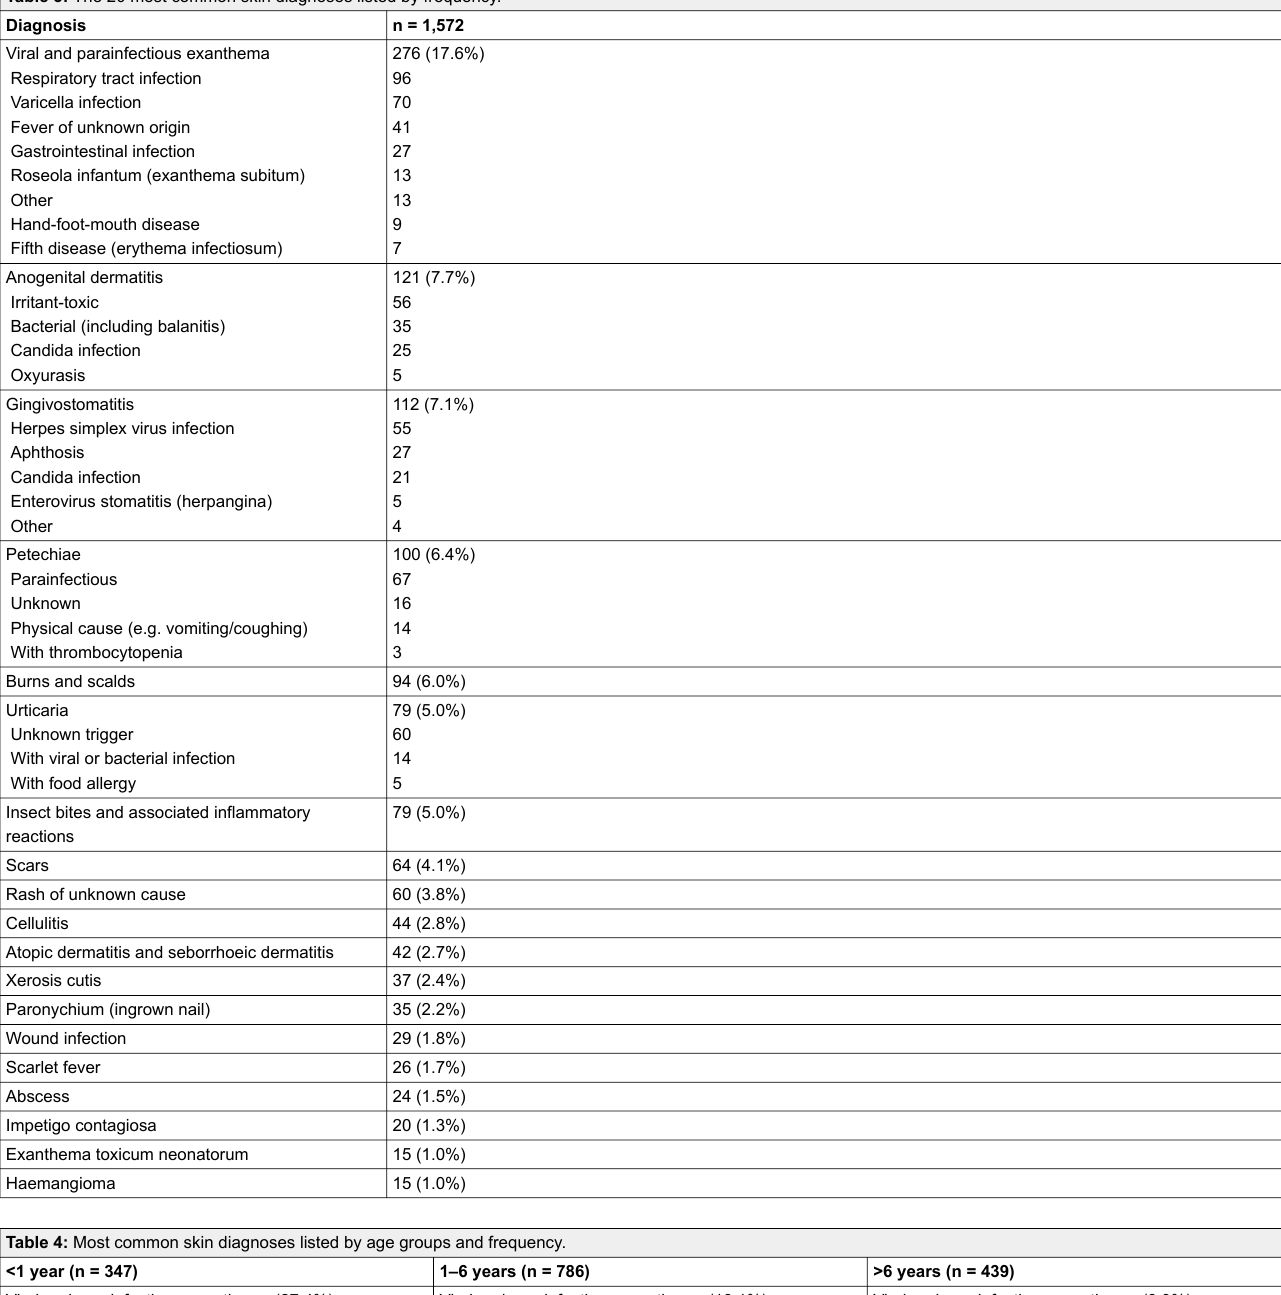
Table 3: The 20 most common skin diagnoses listed by frequency. Diagnosis n = 1,572 Viral and parainfectious exanthema Respiratory tract infection